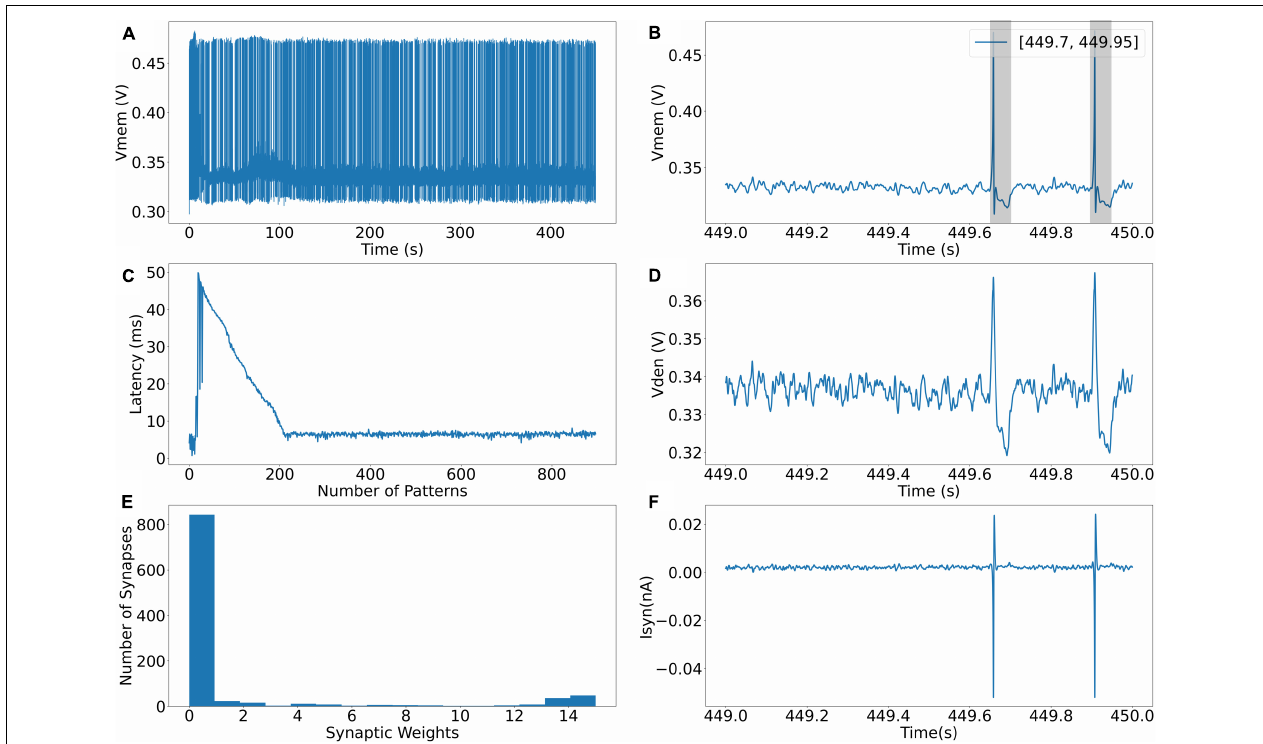
FIGURE 4 | (A) Evolution of membrane potential during training. (B) Membrane potential of the somatic compartment during the last second, neuron only spikes where the pattern exists. (C) Latency to spike within the 50 ms long pattern. (D) Membrane potential of the dendritic compartment during the last second. (E) Bimodal distribution of synaptic weights after learning. (F) Synaptic current flowing into the somatic compartment via the unidirectional resistor.